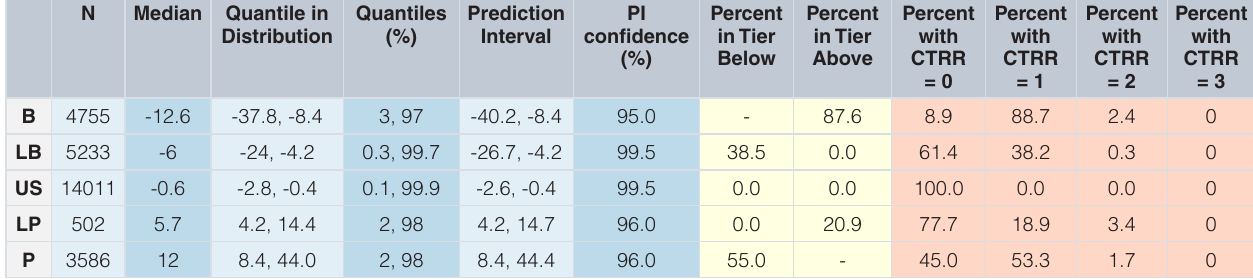
Table 2. Control groups for Clinotator calibration. CTRR, Clinotator Reclassification Recommendation. B, Benign; LB, Likely Benign; US, Uncertain Significance; LP, Likely Pathogenic; P, Pathogenic; PI, prediction interval. N Median Quantile in Quantiles Prediction Distribution (%)